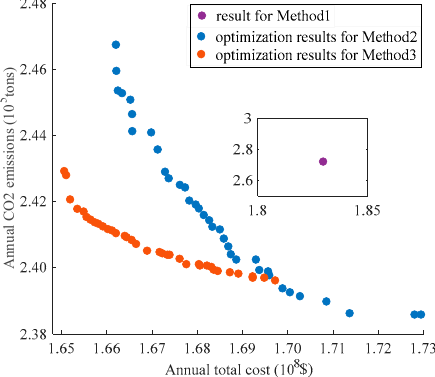
Figure 10. Comparison of results from the three methods.